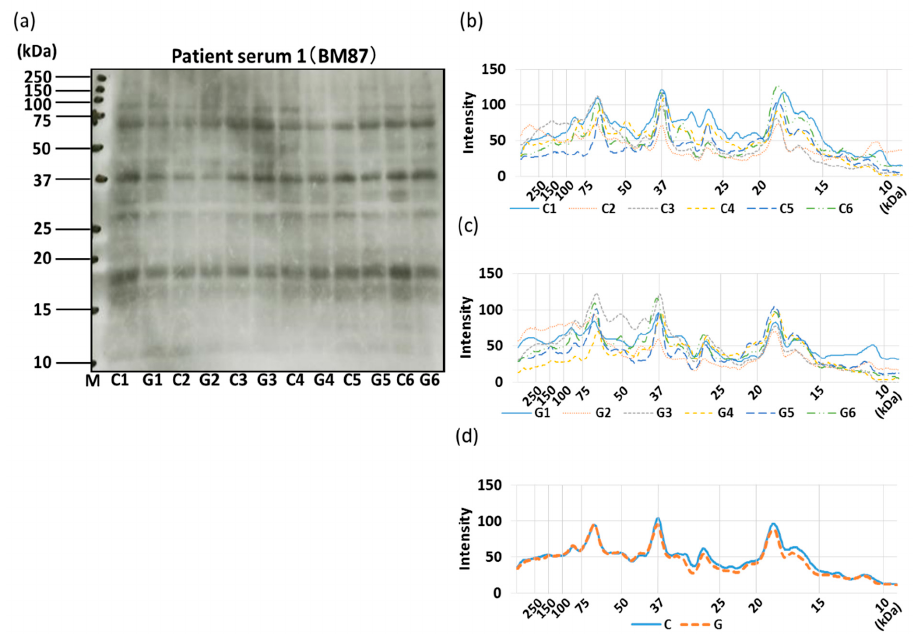
Figure 11 . IgE-immunoblotting of GM-and non-GM soybeans using patient serum 1. A representative IgE-immunoblot of GM soybeans (G1–G6) and non-GM soybeans (C1–C6) is shown (a) . Immunoblots were analyzed on each soybean sample once by densitometry and separated into non-GM soybean (b) and GM soybean groups (c) . The average IgE-immunoblot profiles of non-GM soybeans and GM soybeans were calculated (d) .